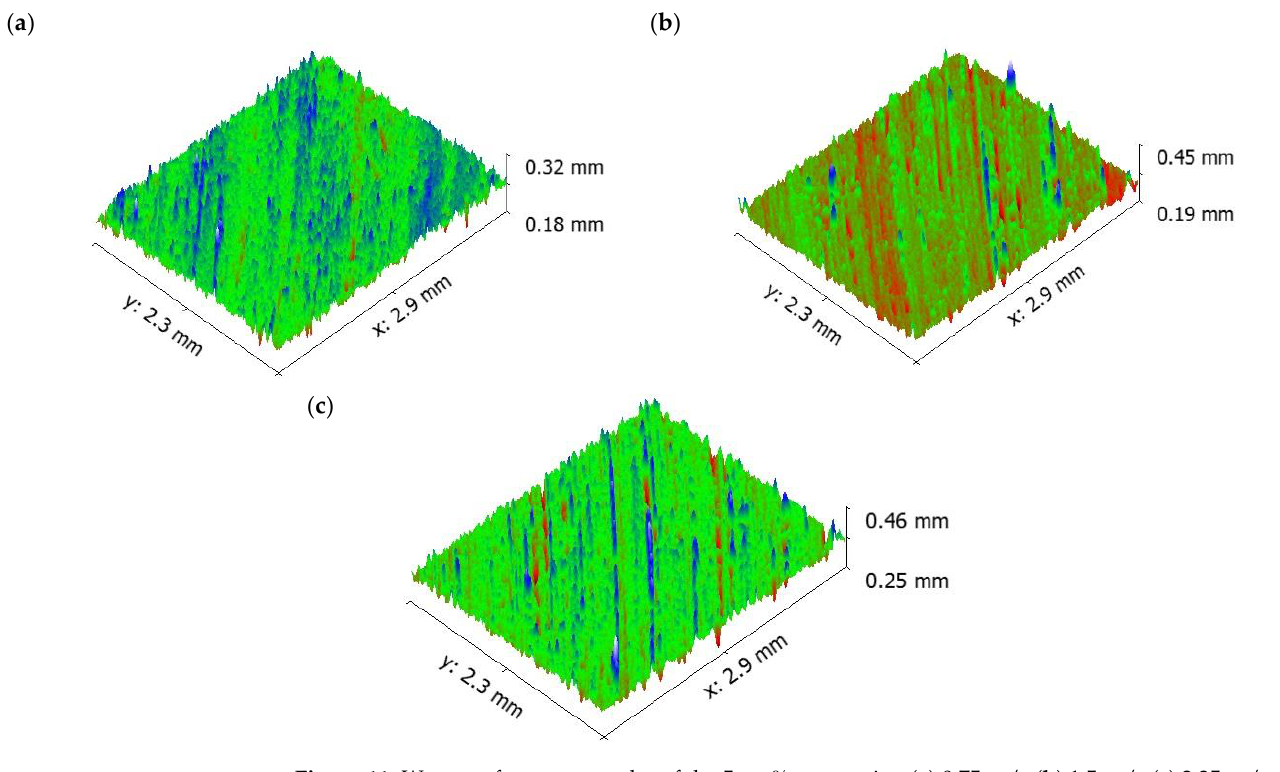
Figure 11. Worn surface topography of the 5 wt.% composite: ( a ) 0.75 m/s ( b ) 1.5 m/s ( c ) 2.25 m/s.